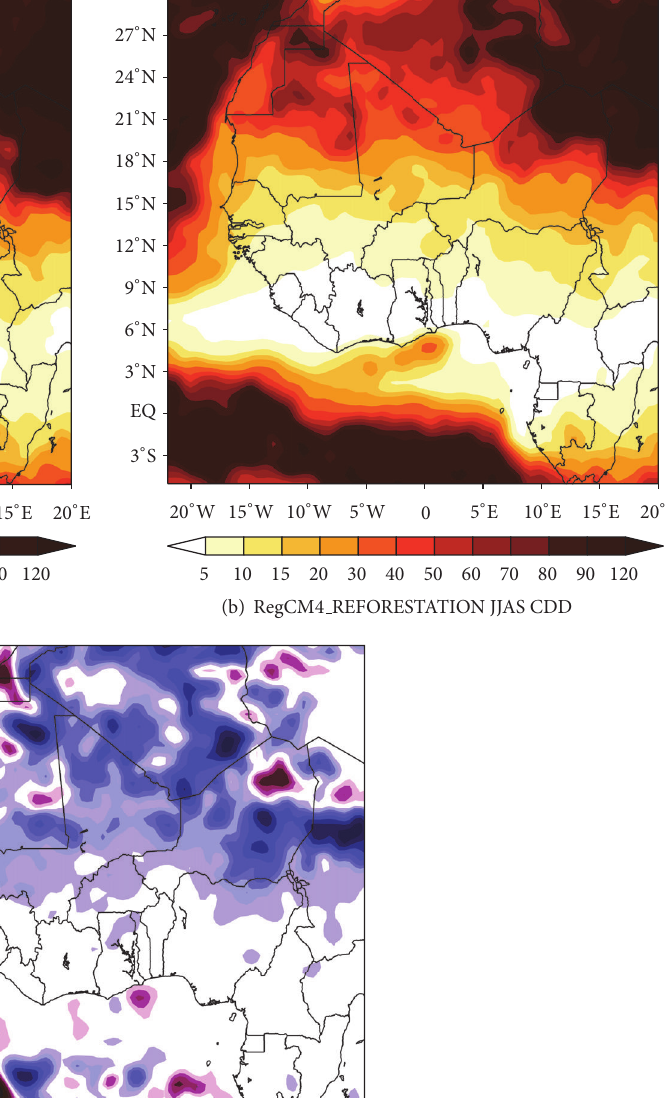
that this land cover change highly influences extreme rainfall